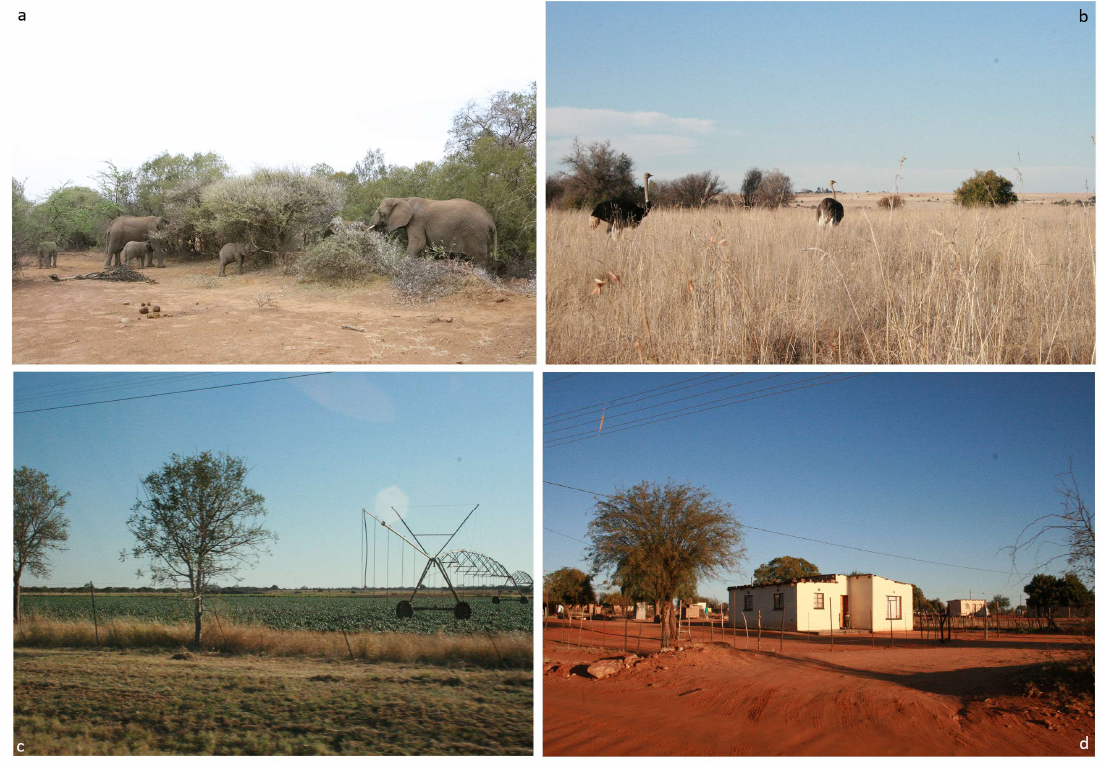
Figure 2. Examples of the four main land cover classes of the study area: ( a ) woody vegetation; ( b ) grassland; ( c ) cropland, and ( d ) non-vegetated land.